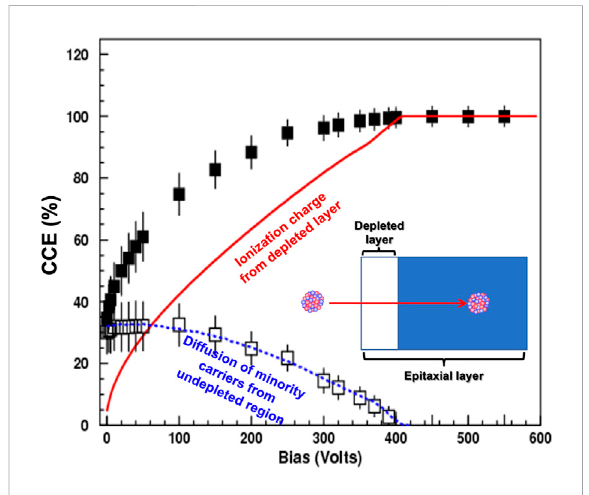
FIGURE 4 CCE of a SiC Shottky diode used to detect 27.7 MeV 12 C as a function of the operating bias. The theoretical values obtained from Eq. 5 are represented by a solid line. The contribution of minority carriers diffusing from the undepleted region of the expitaxial layer is represented by the differences between experimental points and theoretical predictions of Eq. 5 (empty squares). This contribution is well fi tted using Eq. 6 with an L p = 5 μ m